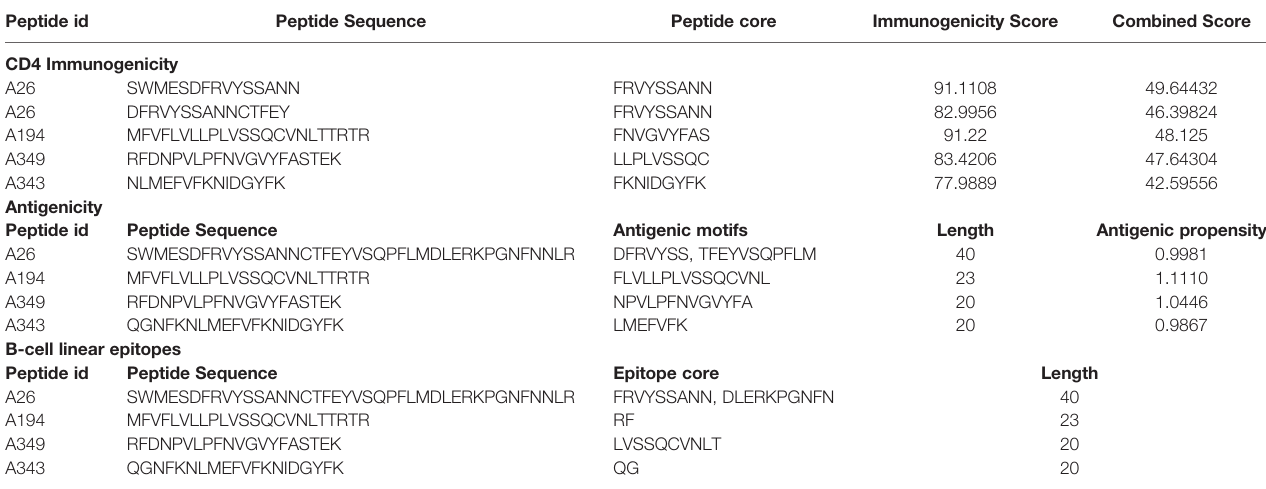
TABLE 3 | CD4 immunogenicity and antigenicity of selected peptides. Peptide